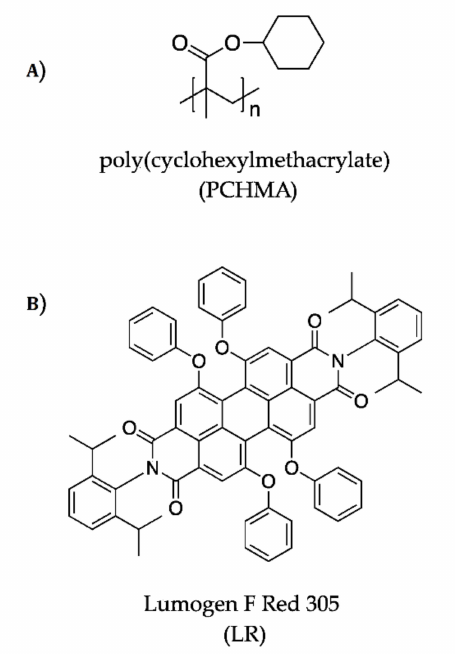
Figure 2. Chemical structures of ( A ) poly(cyclohexylmethacrylate) (PCHMA) and ( B ) Lumogen F Red 305